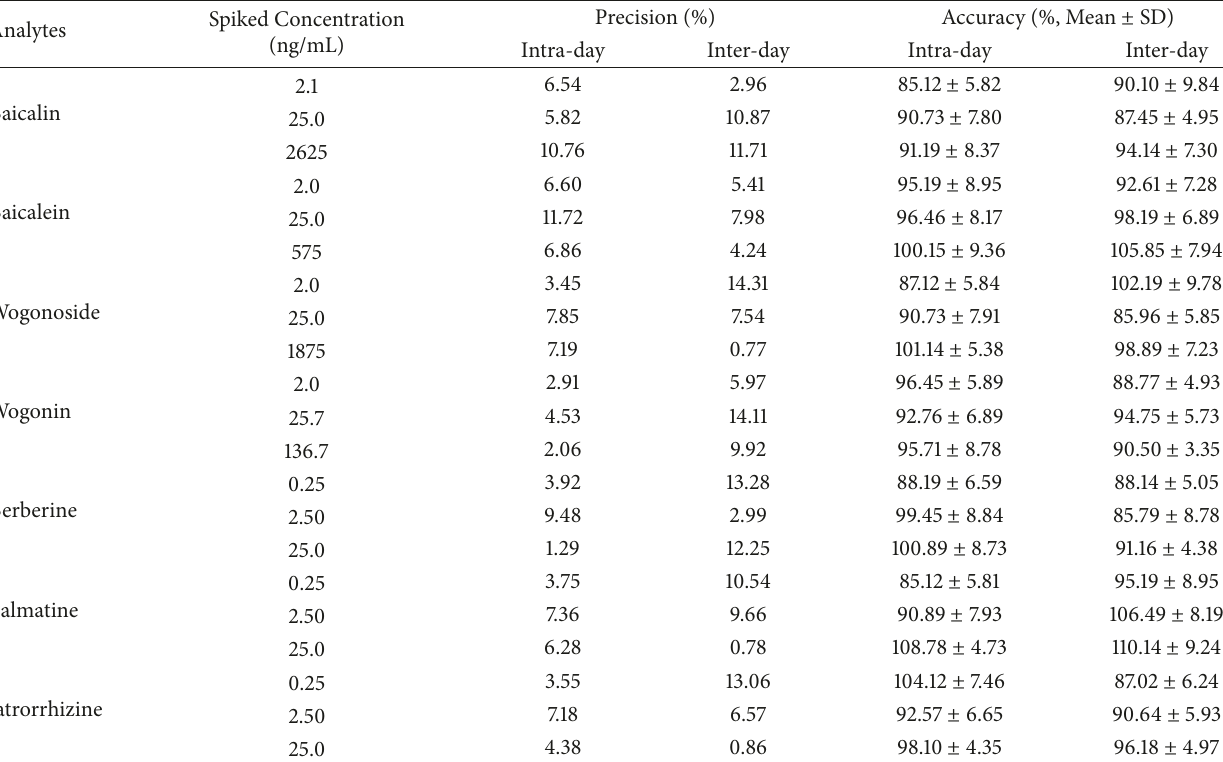
Table 3: Intra-/inter-day precision and accuracy for the determination of the components in rat plasma. Analytes